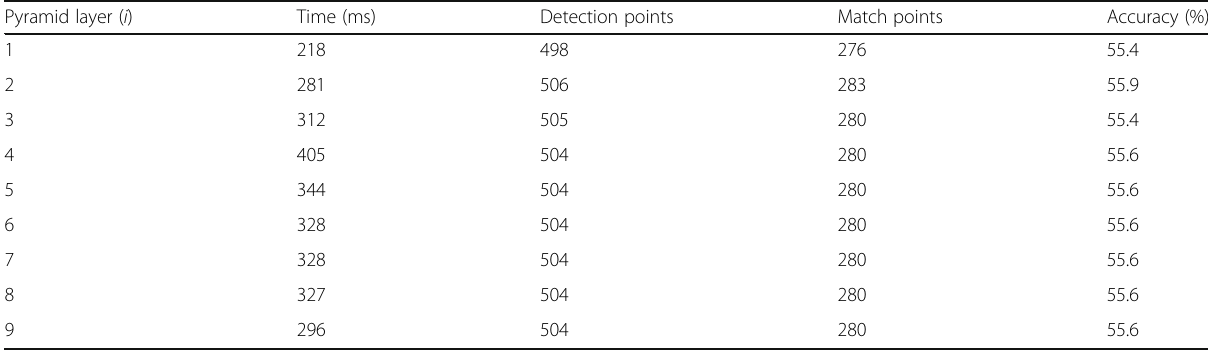
Table 2 Statistical results of experimental results with constant number of layers when the scale parameter between pyramid images is